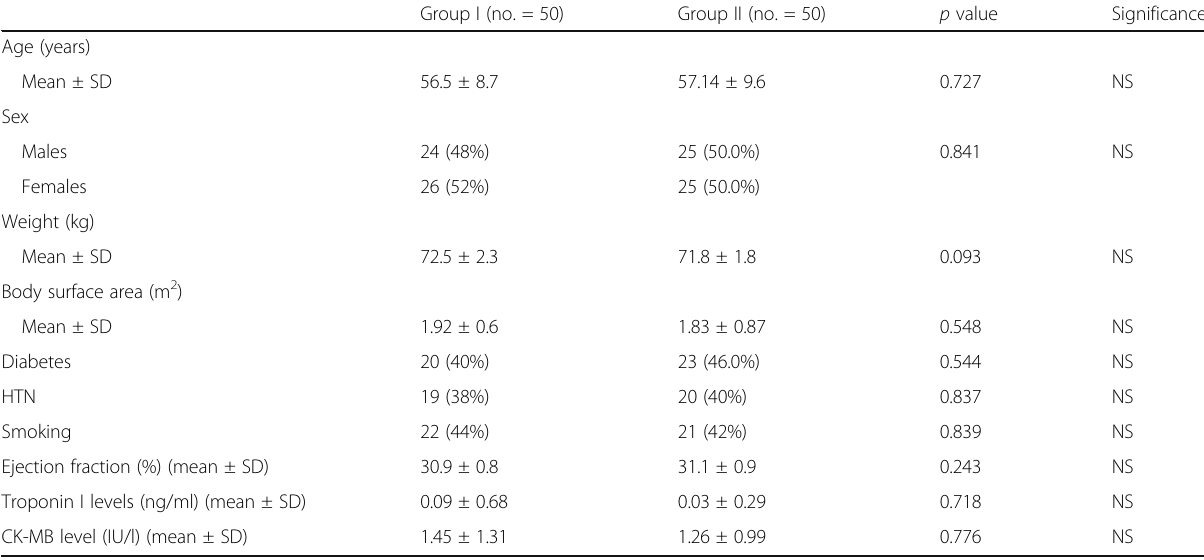
Table 1 Preoperative data